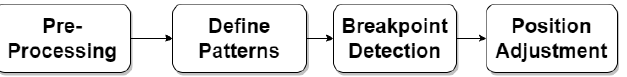
Figure 14. Workflow2: Pattern recognition.